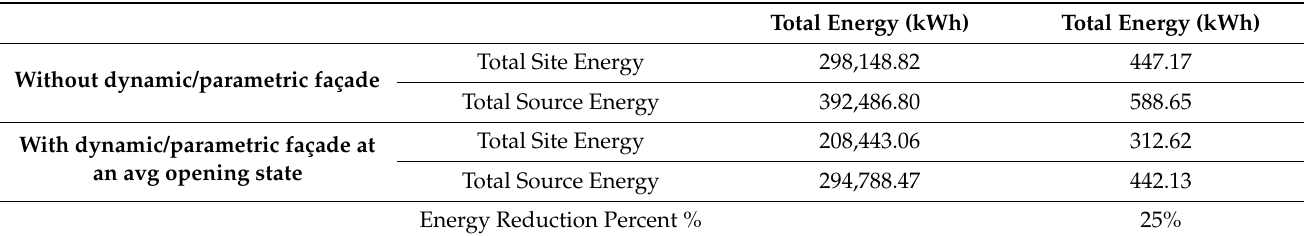
Table 3. Energy simulation results. Table 3 . Energy simulation results.